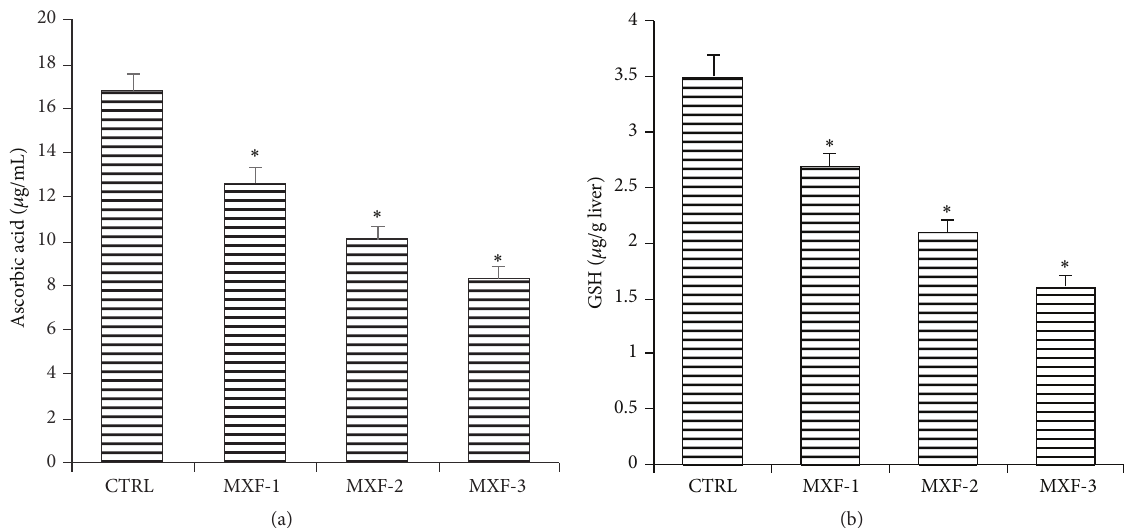
Figure 3: Influence of MXF on hepatic level of nonenzymatic antioxidants (a) ascorbic acid and (b) reduced glutathione levels in rat. Values represent the mean ± SD of six replicates. ∗ Significantly different from control ( 𝑃 < 0.05 ).